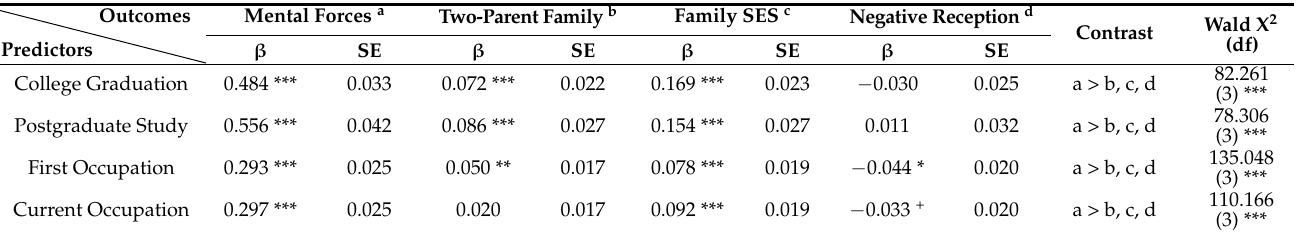
Table 7. Comparing Standardized Effects of Mental Forces and Social Forces by Parameter Constraints from Multilevel Modeling.